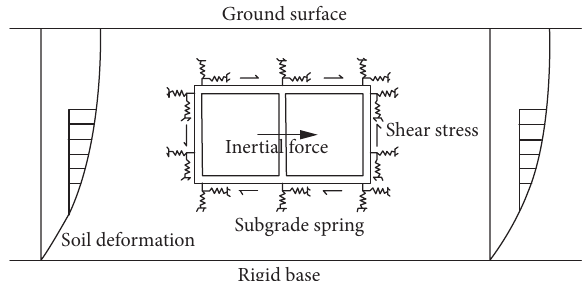
Figure 1: Schematic diagram of response displacement